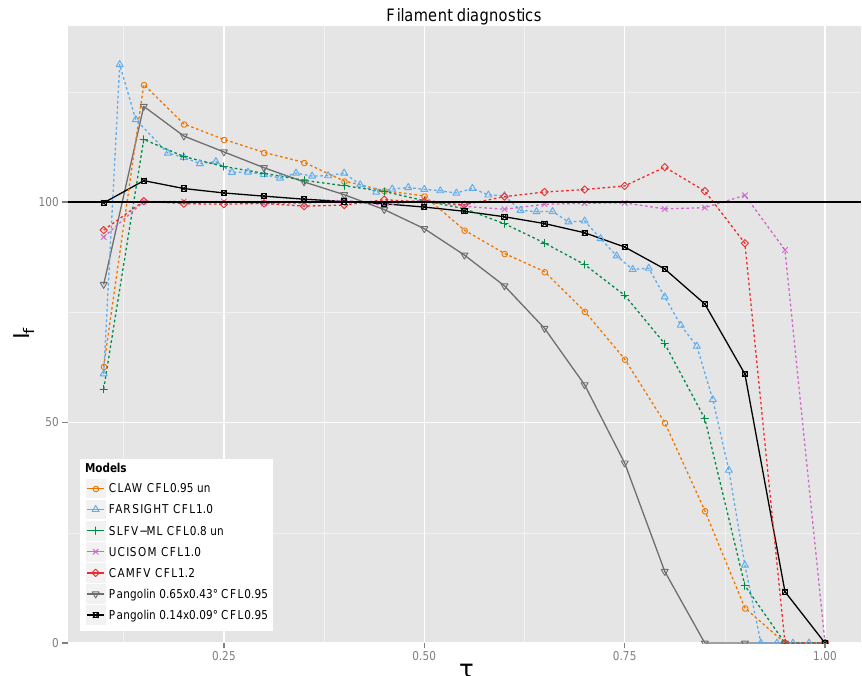
Figure 10. Filament diagnostics between for Pangolin (solid line) and other models (dashed line). By default, the shape-preserving version is used. Only CLAW and SLFV-ML use an “unlimited” version.